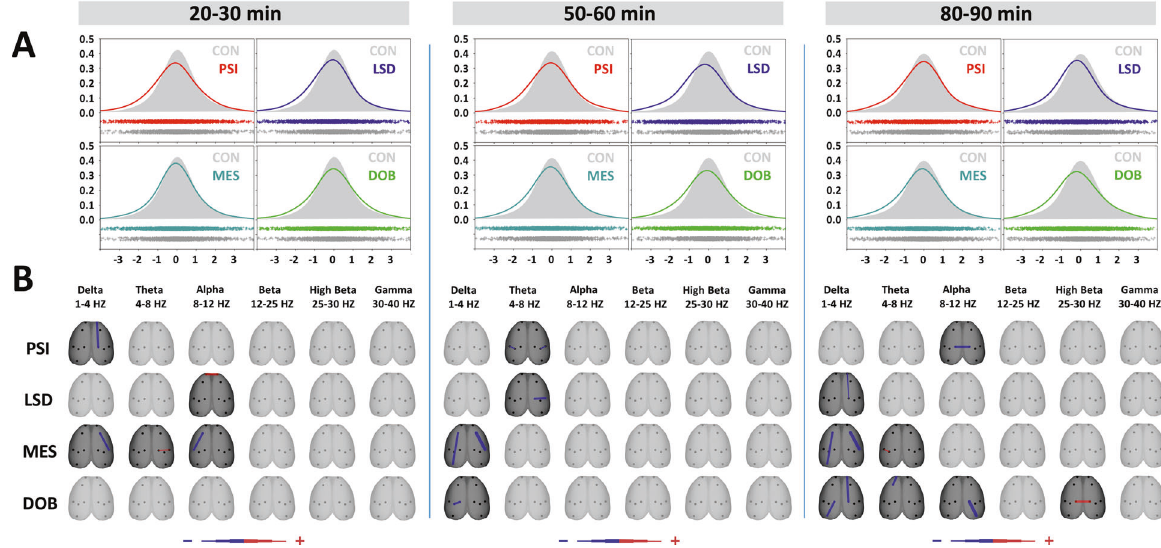
Fig. 4 The effects of treatments on phase-lagged coherence in three time epochs. A Global phase-lagged coherence connectivity. Each fi gure contains estimated probability distributions of connectivity in a sense + / − (increase decrease) following drug treatment (solid line) vs control ( fi lled area) condition. The curve is representing the reduced dimensionality of global connectivity generated from all coherence between all electrode pairs across all frequency bands and all animals into 2D space. A negative or positive change of global functional connectivity in a drug condition is indicated by its shifted distribution towards negative or positive values with respect to the control condition. In the scatterplots below each graph, each individual dot represents one value of individual functional connectivity of one subject/ electrode pair/in a de fi ned frequency band obtained by the Kernel Density Estimator (KDE). CON (control group, saline 2 ml/kg, gray), PSI (psilocin, 4 mg/kg, red), LSD (lysergic acid diethylamide 0.2 mg/kg, blue), MES (mescaline 100 mg/kg, teal), DOB 5 (2,5-dimethoxy-4- bromoamphetamine, 5 mg/kg, green). B , EEG phase-lagged coherence topographic maps — all treatments compared against the control group, drugs in rows, frequency bands in columns; Only signi fi cant change is displayed ( P < 0.05), the direction of change is indicated by the color — decrease in blue, increase in red. The level of relative difference is indicated by a three-level-scaled line width < − 3, − 2, − 1, 1, 2, 3 > , see the theta and alpha power in the temporal and visual cortices for LSD and mescaline appeared in the last epoch. Coherence . Probability distribution graphs in Figs. 3A and 4A demonstrate the global connectivity patterns by comparing drug and control distributions of all coherence changes. While a control condition resulted in symmetrical distributions around zero, all active substances pull the course of the curve to the left to negative values. Distribution graphs of phase-lagged coherences are generally more scattered and less uniform than those of cross- spectral coherence. Coherence topographic maps in Figs. 3B and 4B show discrete changes of coherence between electrode pairs over a cortical surface for different frequency bands and three consecutive time epochs. Repeated-measures ANOVA revealed that all treatments induced a decrease in synchronization. While changes in cross- spectral coherence affected the entire frequency spectrum, phase- lagged coherence analysis indicated decreases mainly in the lower frequency bands. Also, phenethylamine derivatives were shown to be more potent in inducing connectivity changes compared to tryptamine derivatives.